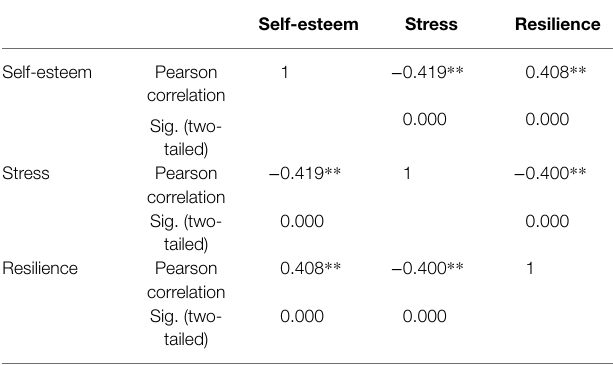
TABLE 1 | Pearson correlations between self-esteem, perceived stress, and resilience ( N = 290). Self-esteem